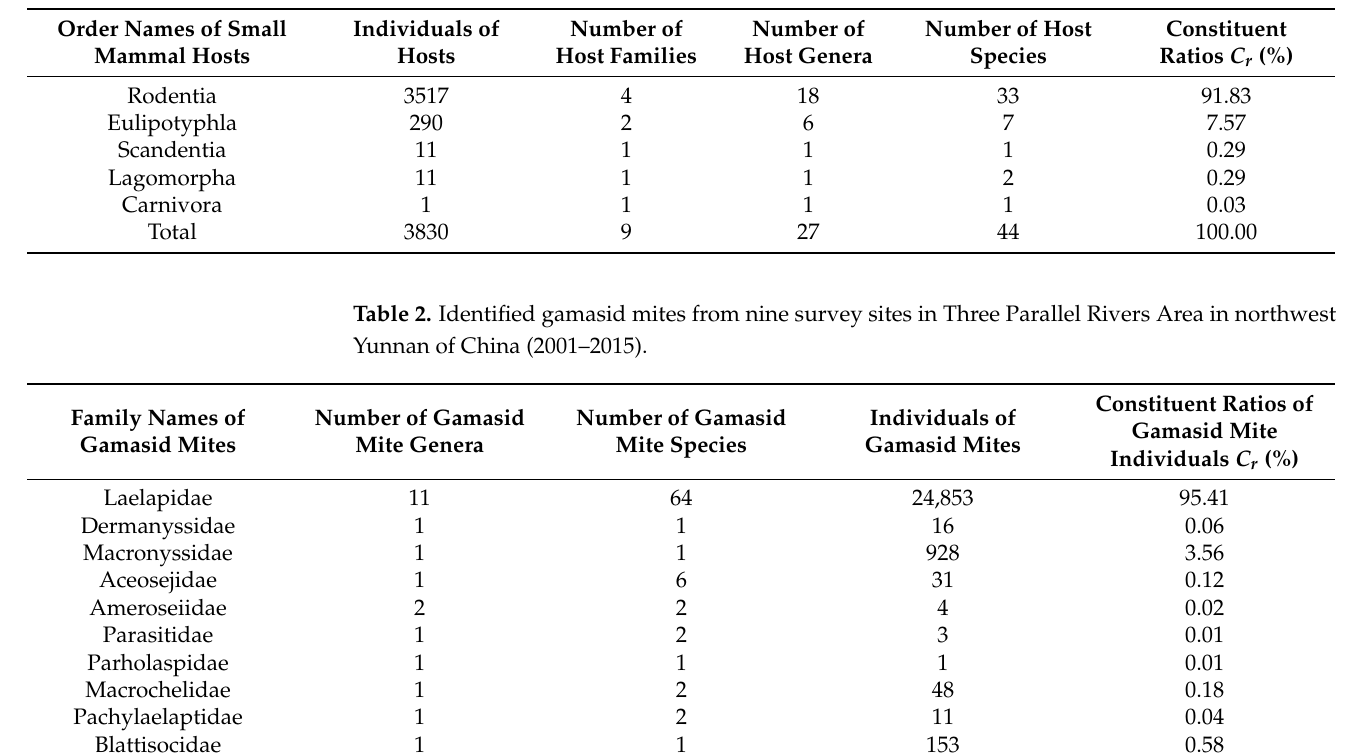
Table 1. Identified small mammal hosts from nine survey sites in Three Parallel Rivers Area in northwest Yunnan of China (2001–2015).